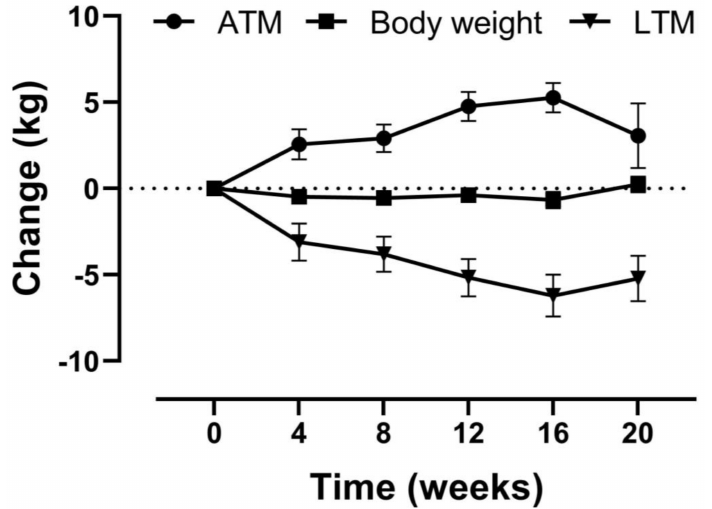
Figure 1. Change in body weight, lean tissue mass (LTM), and adipose tissue mass (ATM) over time. Data are shown as the mean ± SEM. Measurements available for all 54 patients (t = 0, 4 and 8 weeks), 46 patients (t = 12 weeks), 42 patients (t = 16 weeks), and 37 patients (t = 20